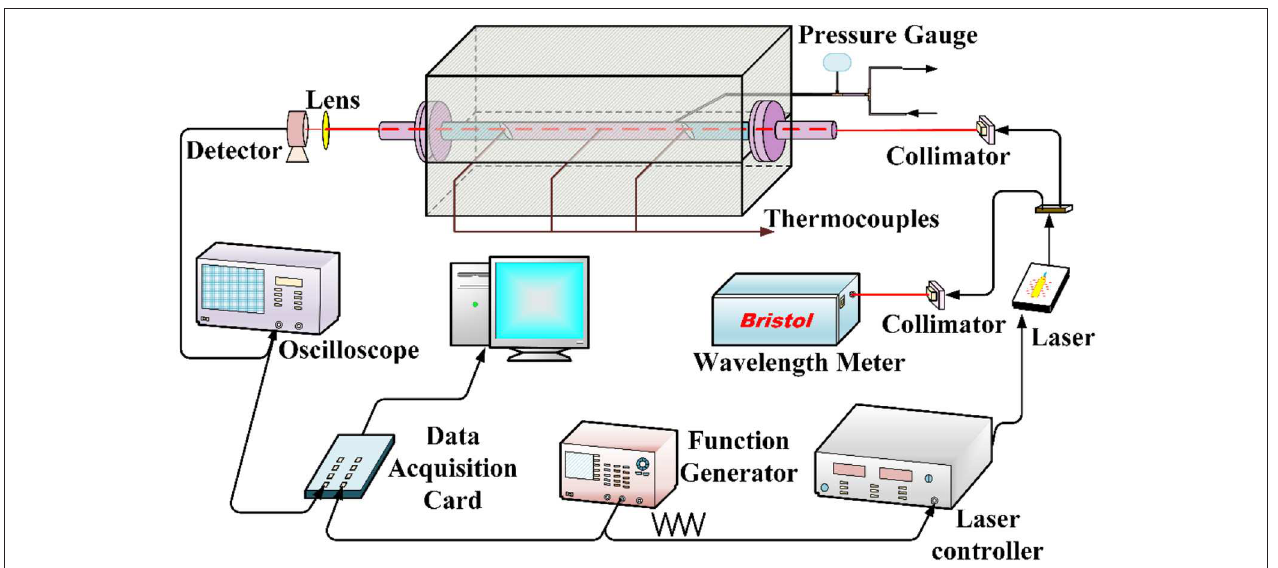
FIGURE 1 | Schematic of the experimental